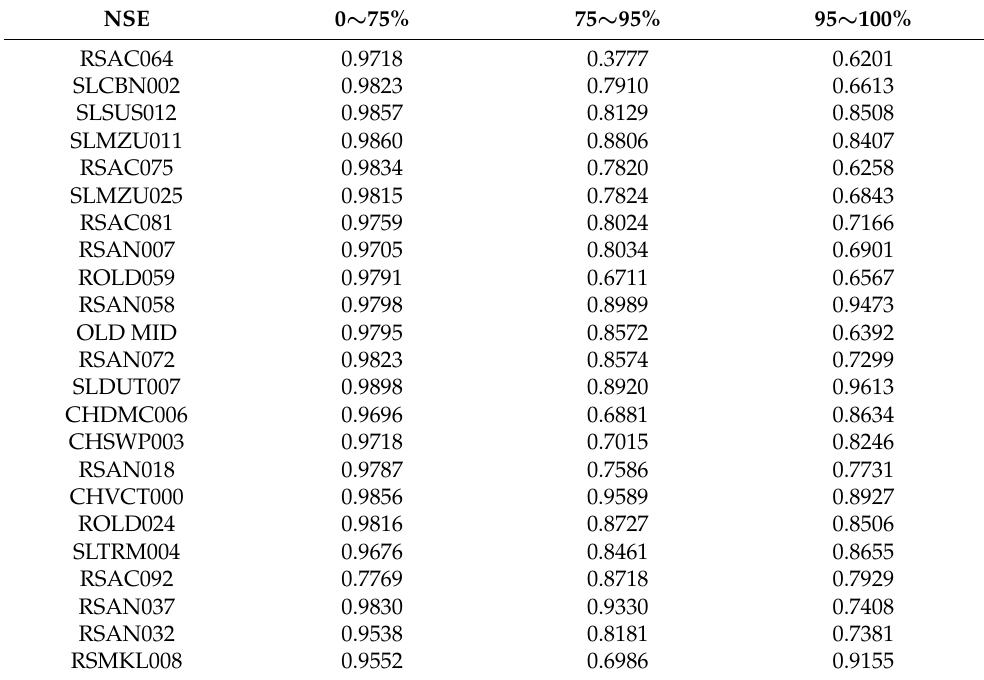
Table A9. Station-wise NSE results of Res-LSTM at daily time step.